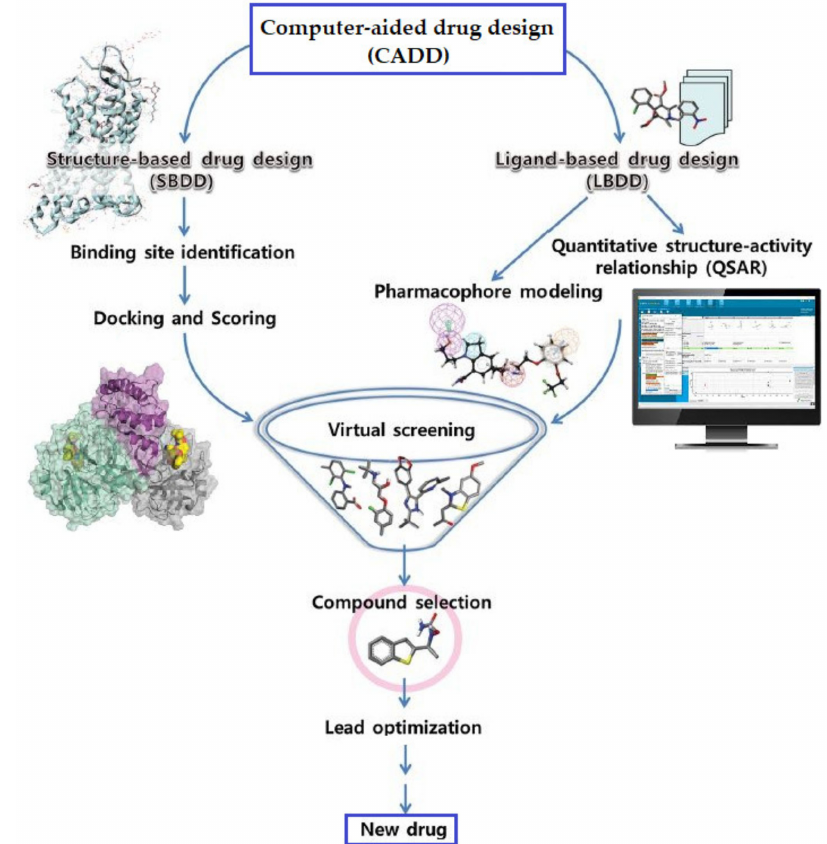
Figure 1. Drug discovery process and computer-aided drug